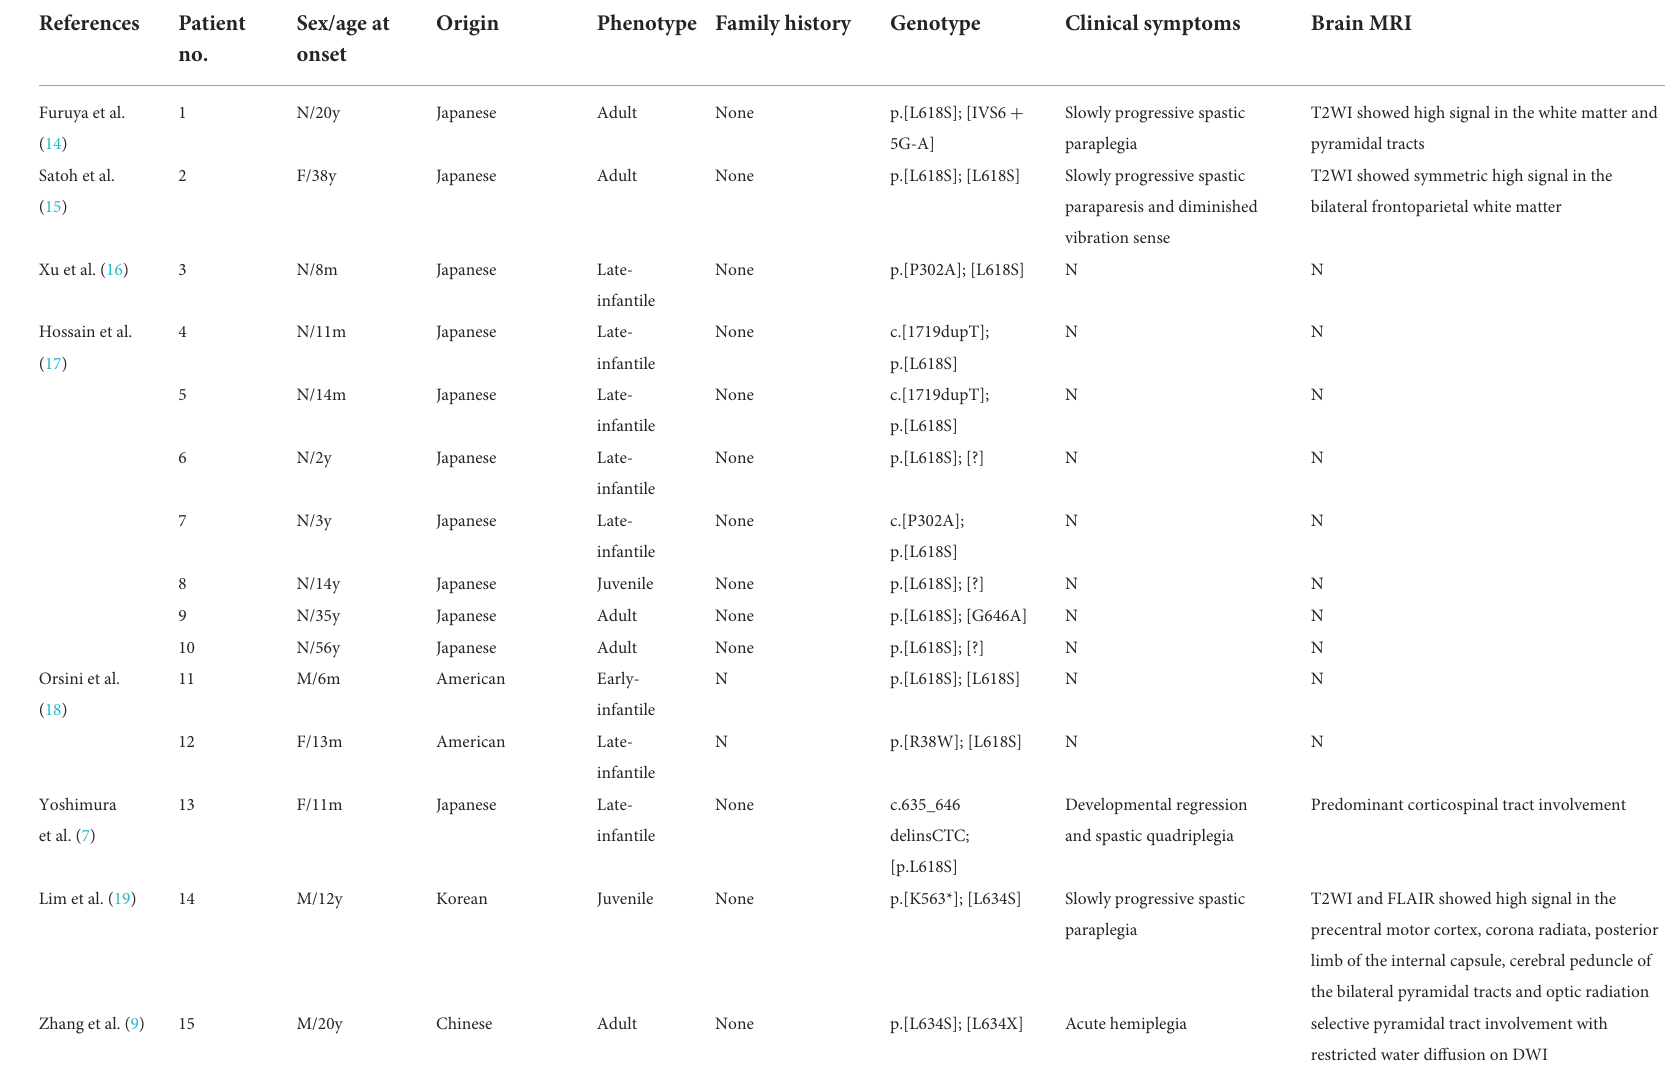
TABLE 1 The clinical and radiological characteristics of Krabbe disease (KD) patients with p.L634S (also known was L618S) mutation previously